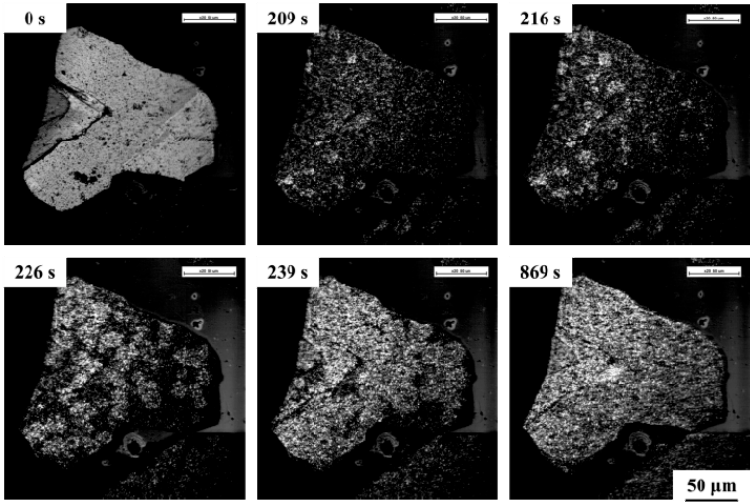
Figure 4. The “blooming” phenomenon during in-situ online observation experiment: 1073 K with 85% CO + 15% CO 2 .